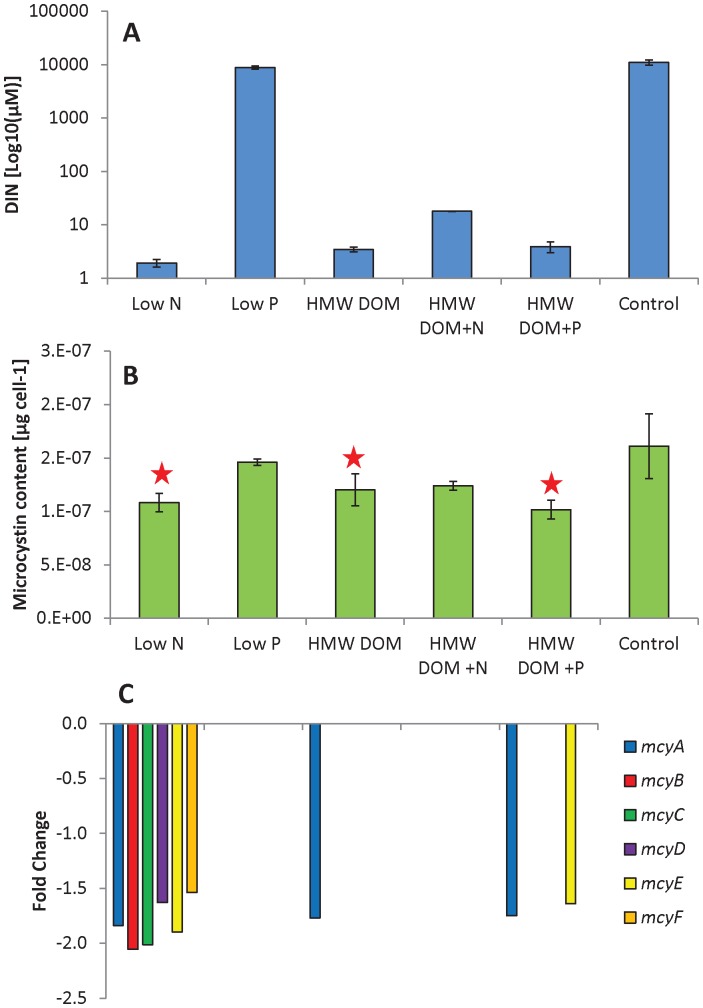
Dissolved inorganic nitrogen, microcystin levels, and mcy gene expression.A) Dissolved inorganic nitrogen (DIN) concentrations at the time of harvest, B) microcystin content per cell at the time of harvest and C) the fold change in gene expression relative to the control of microcystin synthetase genes. Bars represent means and error bars represent standard deviation among three biological replicates. Stars indicate significant differences relative to the control (p<0.05, Tukey Test).